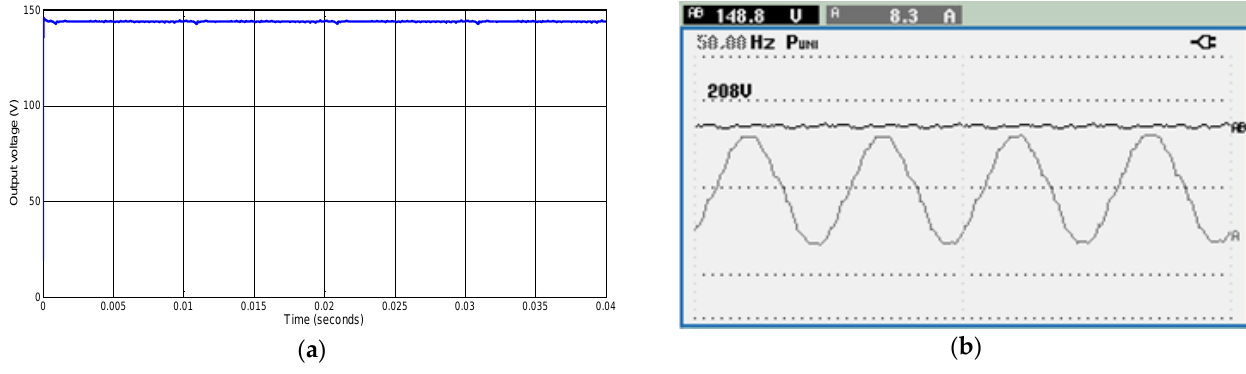
Figure 11. The voltage waveform across the TIPR: ( a ) simulation results, ( b ) experimental results.